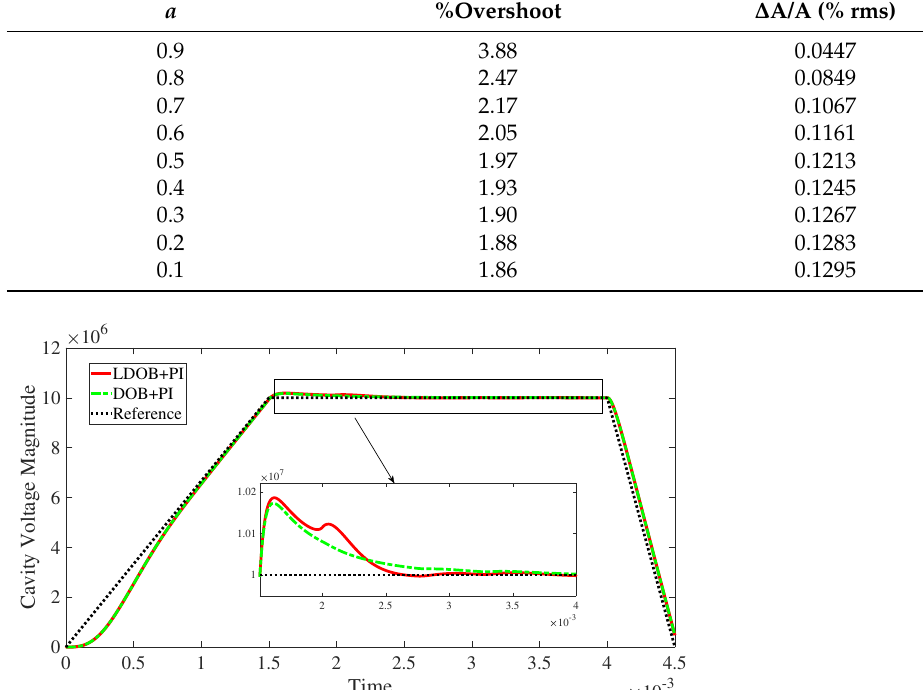
Figure 12. Cavity voltage magnitude for learning-based DOB + PI and conventional DOB + PI controllers, variable recursive coefficient a switched on at 1.5 ms and reaching 0.9 at 2 ms; additional overshoot due to learning-based DOB is